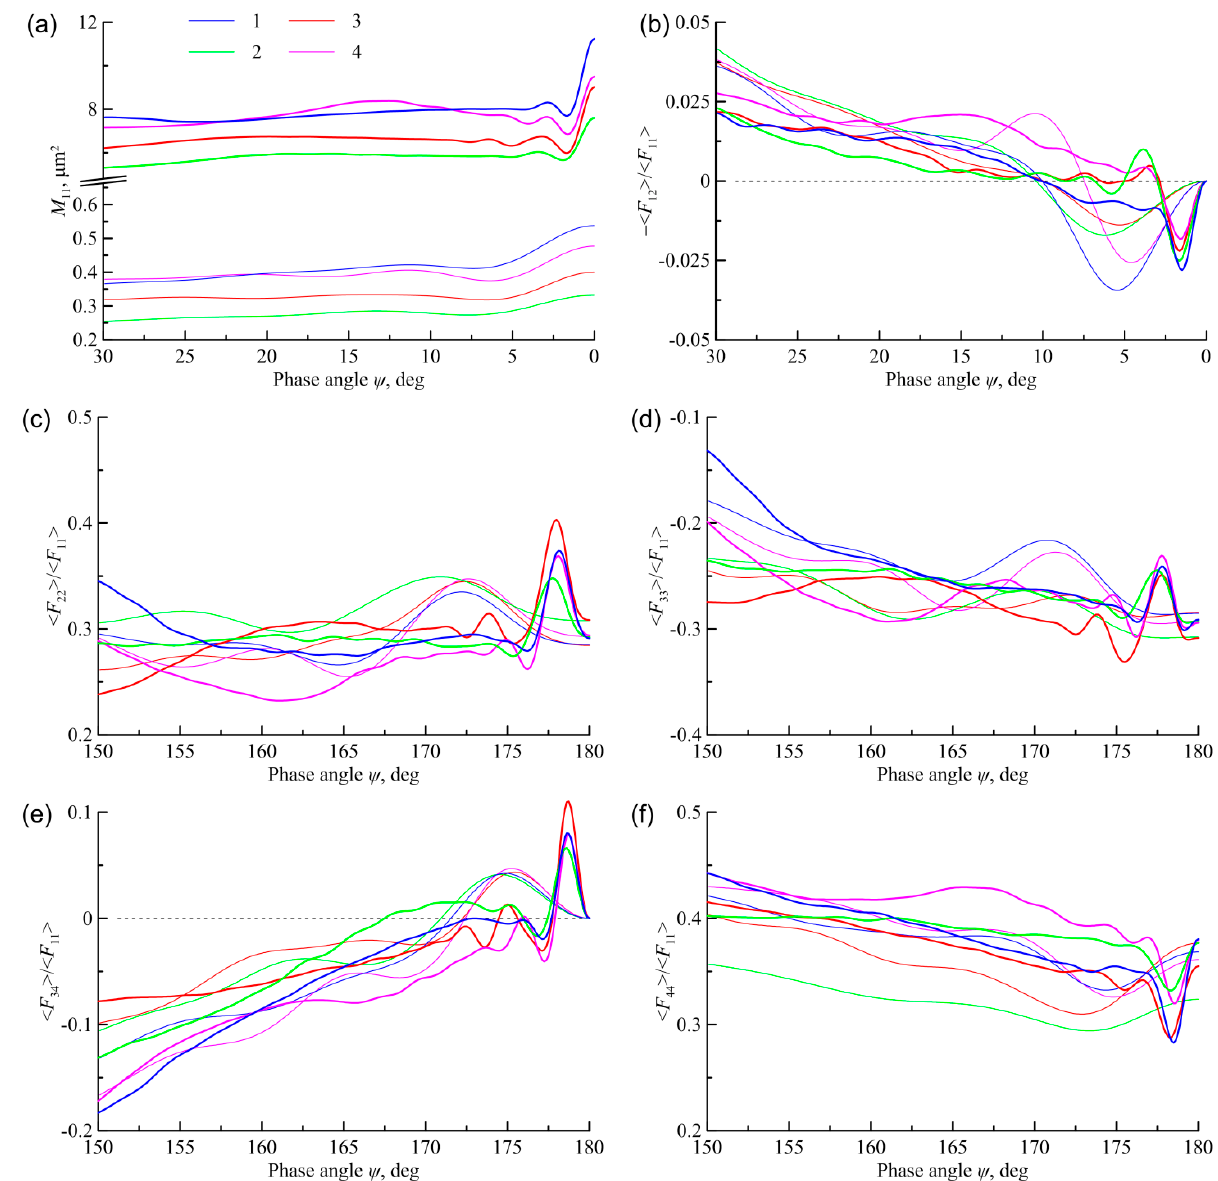
Figure 6. The scattering matrix for particles of Figure 5 with two sizes.